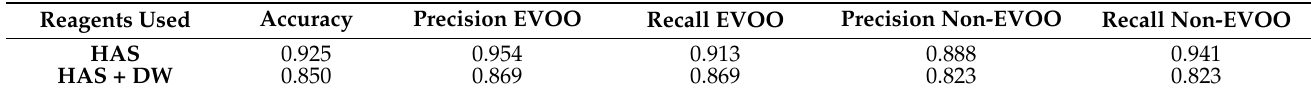
Table 7. Comparison of the classification metrics in the case of two classes classification (EVOO and non-EVOO).